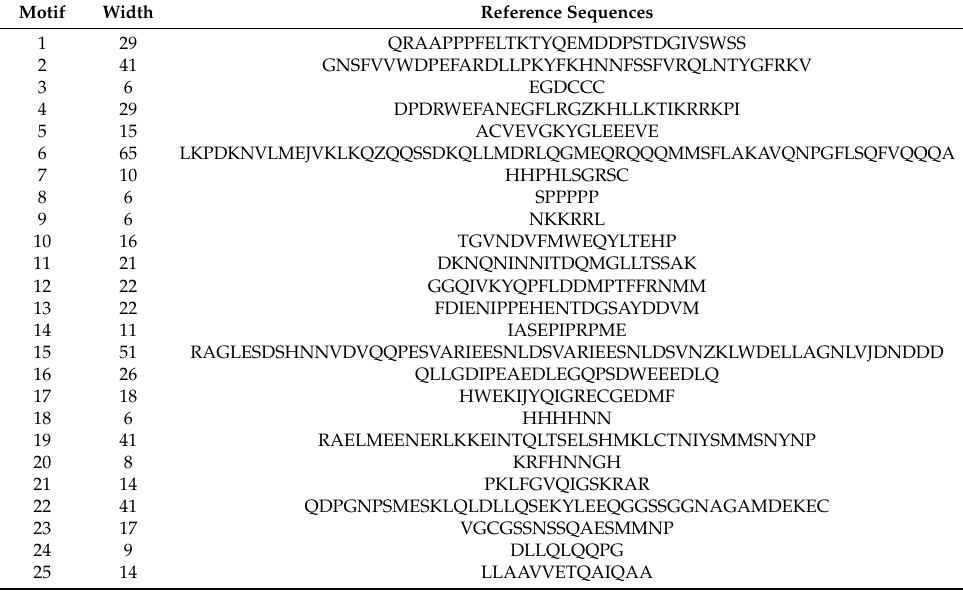
Table 4. Motifs identified by MEME